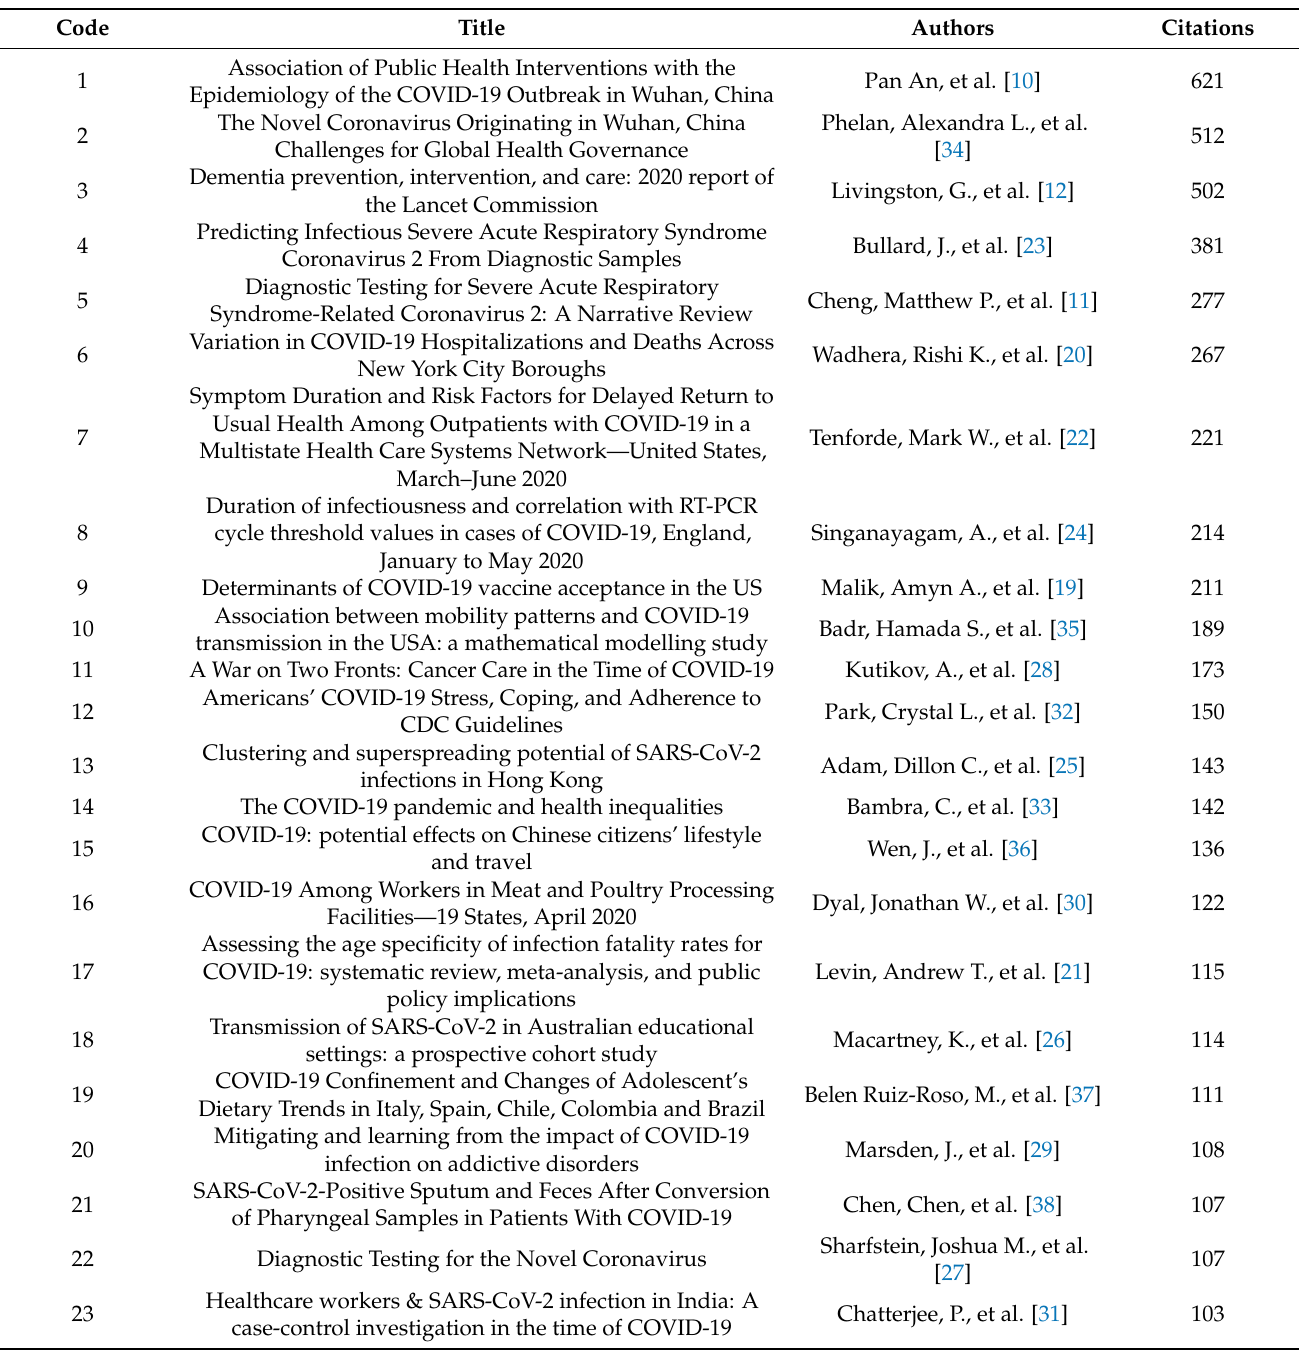
Table 8. Articles with more than 100